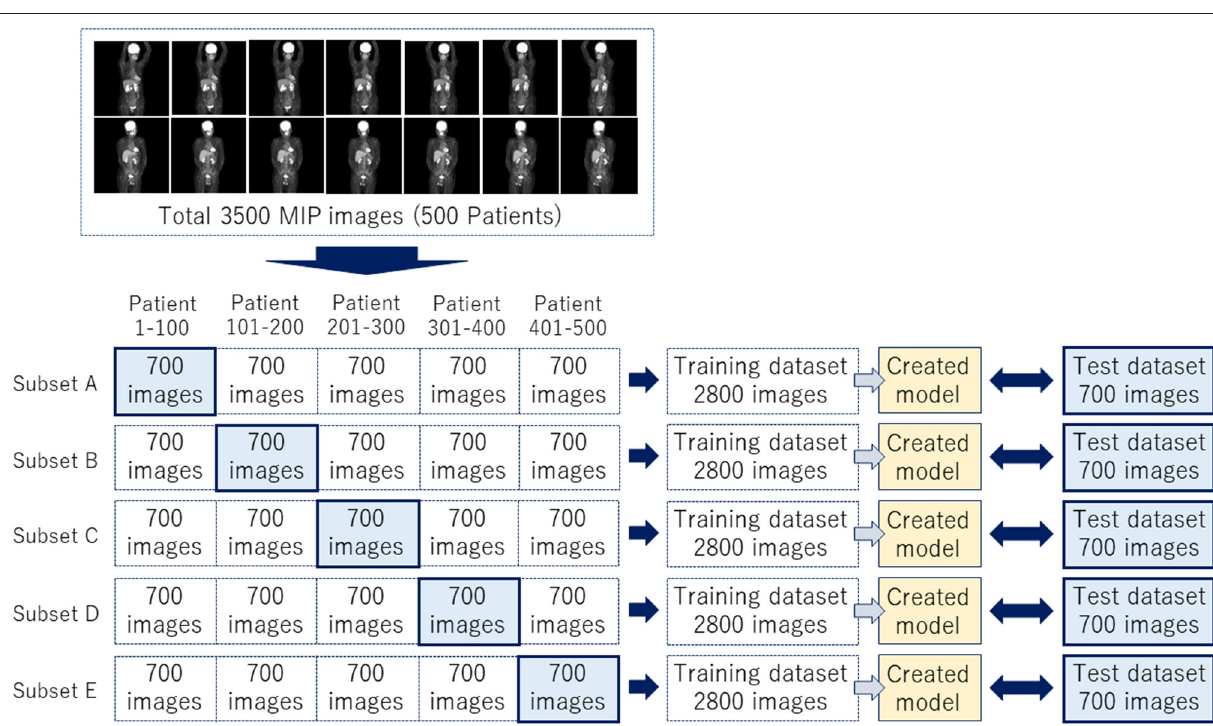
Frontiers in Medicine | www.frontiersin.org